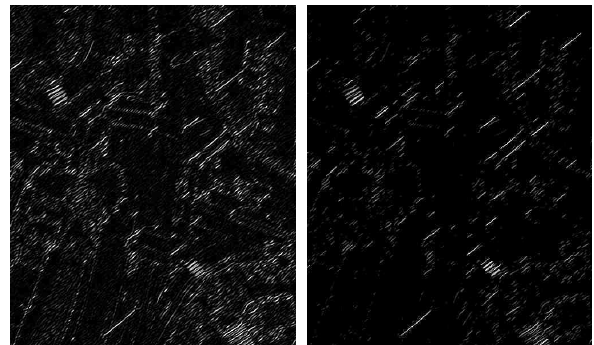
Figure 10. Same section as in fig. 8, left: gabor-filtered G , right: gabor-filtered and dist-max cumulated D